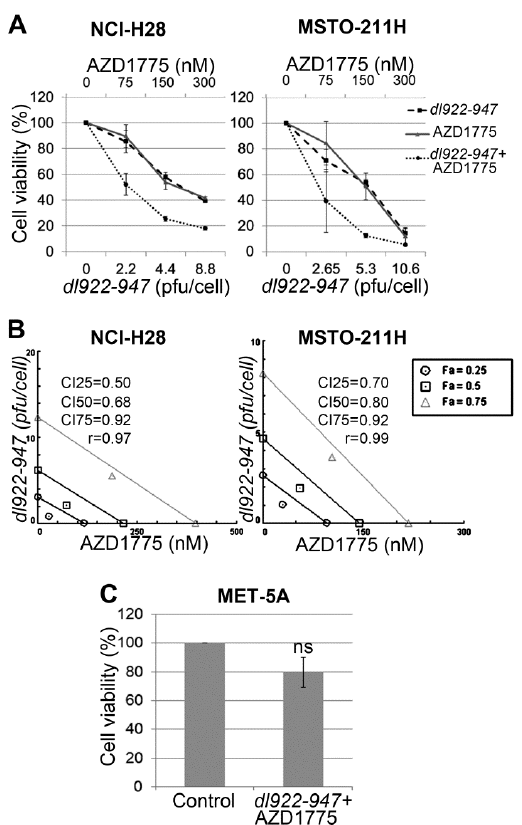
Figure 1. Synergistic effect of dl922-947 -AZD1775 combination on malignant mesothelioma (MM) cell lines. ( A ) Dose–response curves for dl922-947 alone, AZD1775 alone, and dl922-947 -AZD1775